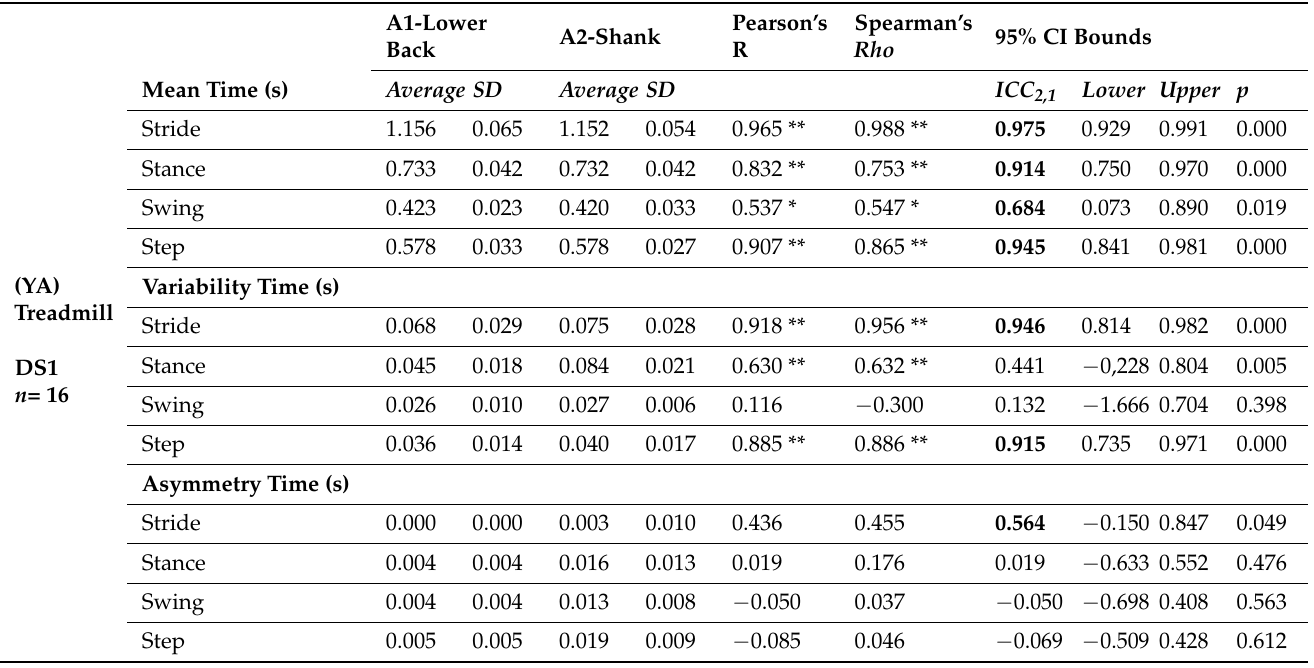
Table 2. Extracted temporal parameters and agreements for treadmill walking.